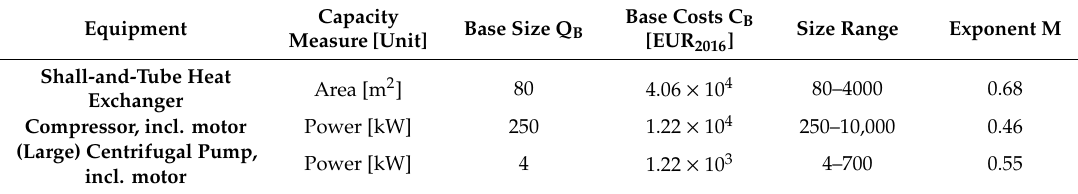
Table A4. Parameters for di ff erent types of equipment according to Smith [41].